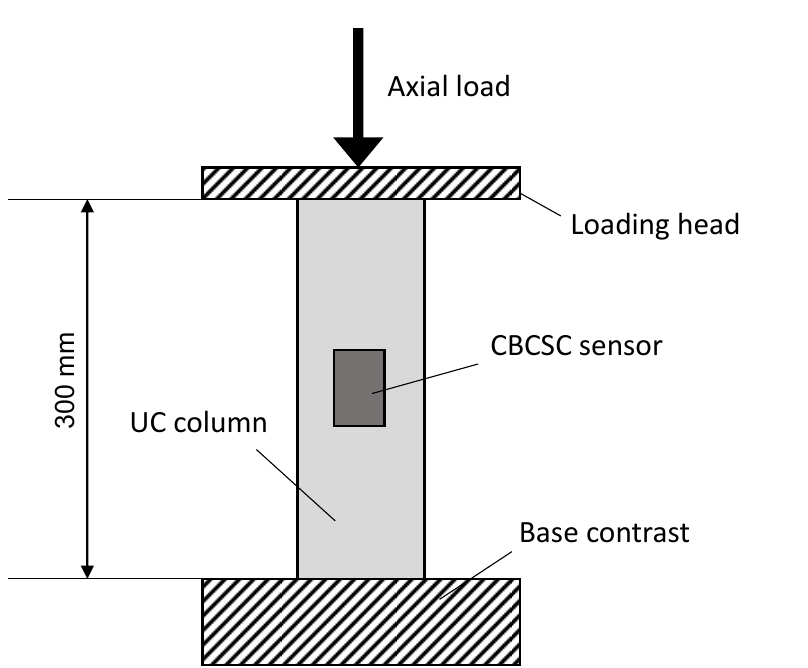
Figure 2. Scheme of testing on embedded CSC sensors (adapted from [71]).